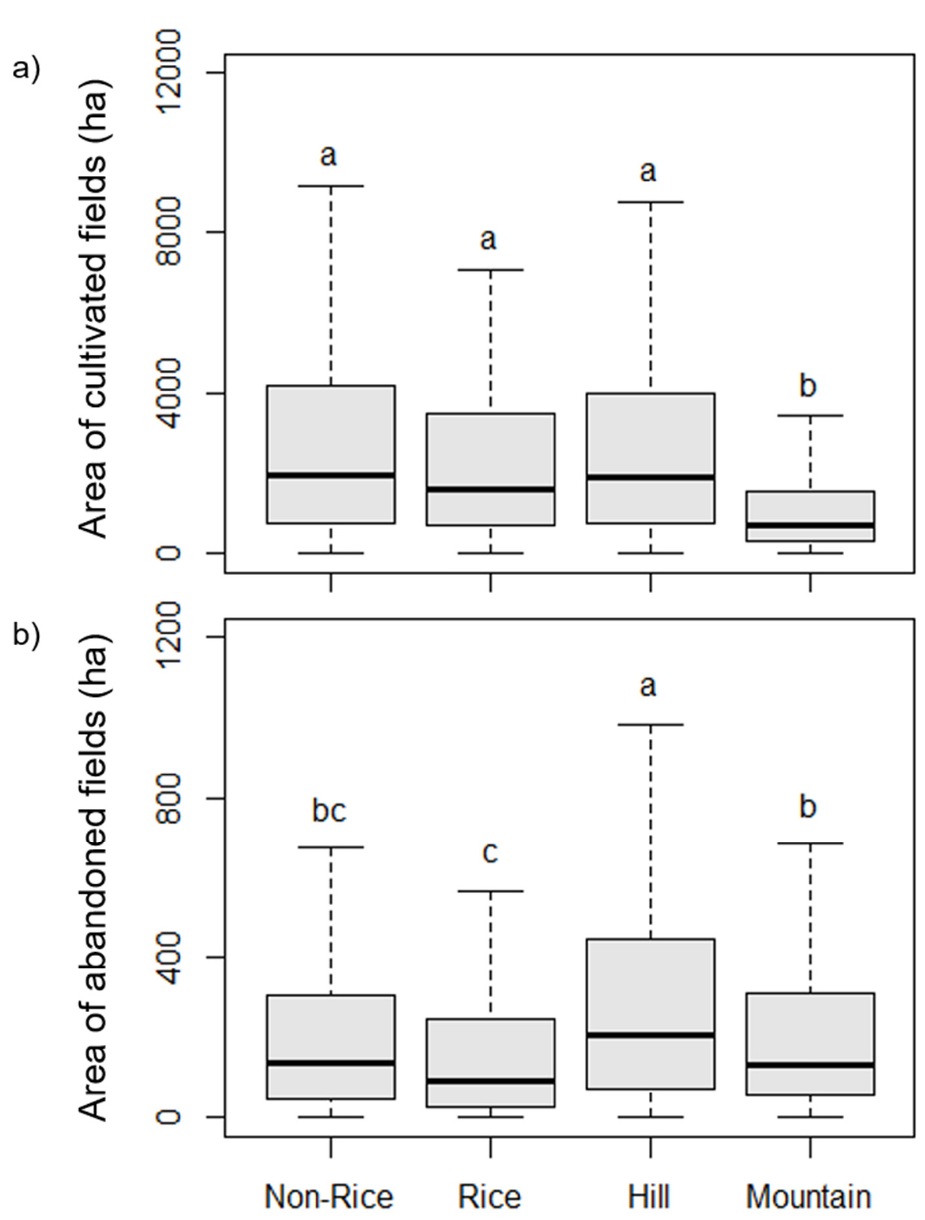
Figure 3. Boxplots comparing the area of ( a ) cultivated fields, and ( b ) abandoned fields in 2015. Significant differences were observed among the bundles (Kruskal–Wallis test all p < 0.001). Different letters indicate significant differences between pairs of bundles (Mann–Whitney U test p <0.05) and are in descending